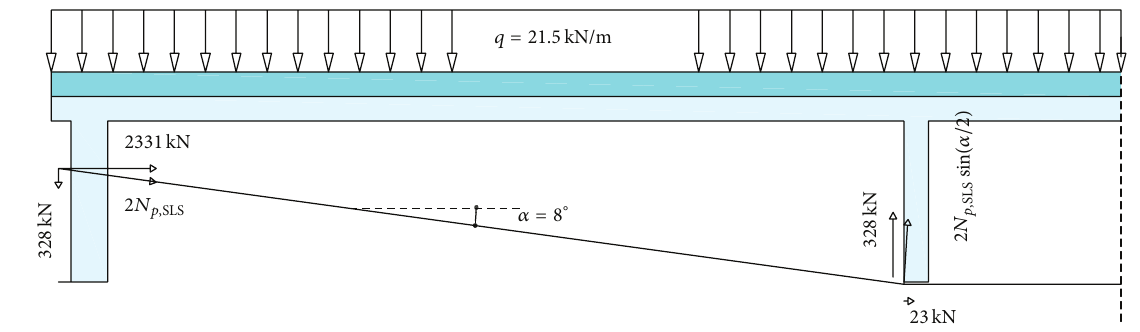
Figure 8: Concentrated forces equivalent to external prestressing actions at support and deviation of external cable sections.